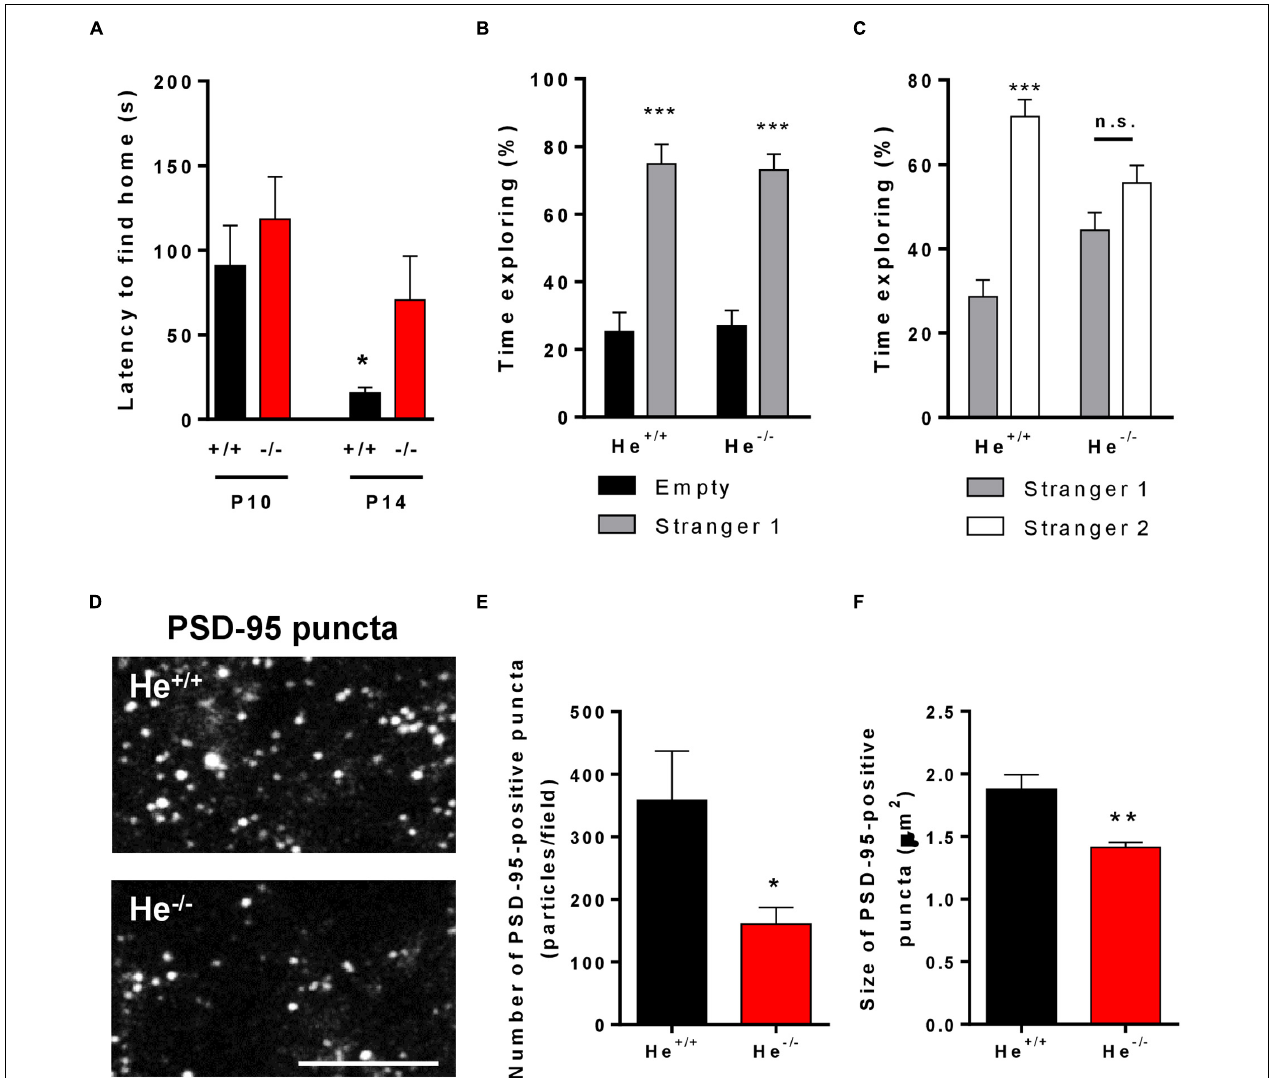
FIGURE 4 | Characterization of schizophrenia-like phenotypes related to hippocampal function in He − / − mice. (A) Latency (in seconds) to reach the maternal area in He + / + and He − / − mice at postnatal day 10 (left, n = 3 He + / + males and 6 He + / + females, and 3 He − / − males and 4 He − / − females) and postnatal day 14 (right, n = 3 He + / + males and 4 He + / + females, and 3 He − / − males and 3 He − / − females). (B) Time exploring the mouse (stranger 1) and empty (empty) cages during socialization in the three-chamber sociability test in 8-week-old He + / + and He − / − mice ( n = 6 He + / + and 6 He − / − ; 3 males and 3 females per genotype). (C) Time exploring the known (stranger 1) and the stranger mouse (stranger 2) cages in the social memory and novelty preference evaluation of the three-chamber sociability test in 8-weeks-old He + / + and He − / − mice. (D) Representative inset (17 × 9 microns) of confocal images immunostained for PSD-95 in CA1 stratum radiatum (63x objective, digital zoom 5). Original area of analysis per field was 65 × 65 microns. For this experiment, 8-week-old He + / + and He − / − mice ( n = 2 He + / + males and 3 He + / + females, and 2 He − / − males and 3 He − / − females) were used. Scale bar = 10 microns. Quantification of the number (E) and size (F) of PSD-95-positive puncta per field. Bars represent mean ± SEM. Data were analyses by Student’s t -test in (A,E,F) and by two-way ANOVA with the Bonferroni’s post hoc test in (B,C) . * p < 0.05, ** p < 0.01 when compared with He + / + mice in (A,E,F) . *** p < 0.001 when compared with “empty” in (B) or “stranger 1” in (C)